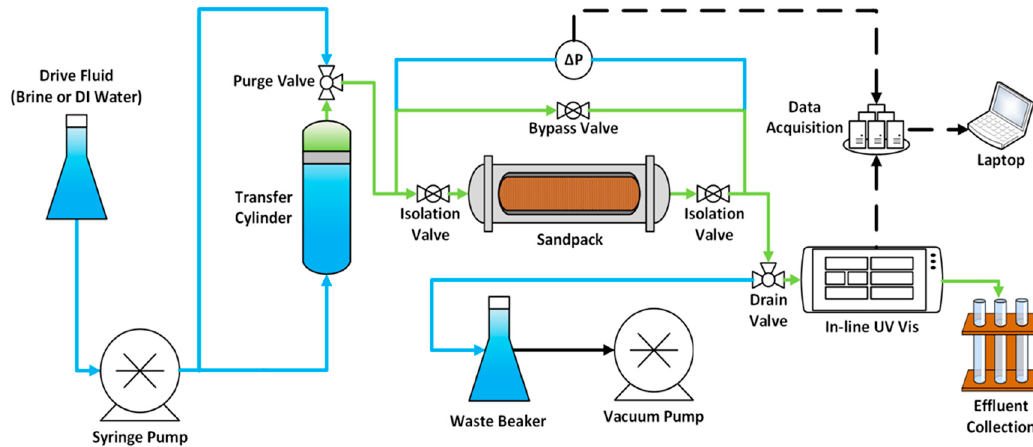
Figure 6. Schematic of the experimental setup used for sandpack retention flood.